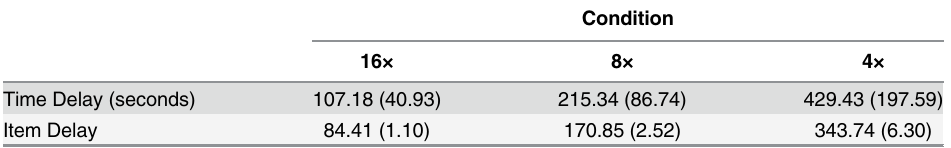
Table 1. Mean Time and Item Delay (with Standard Deviation) Between Repeated Words in the 4×, 8× and 16×